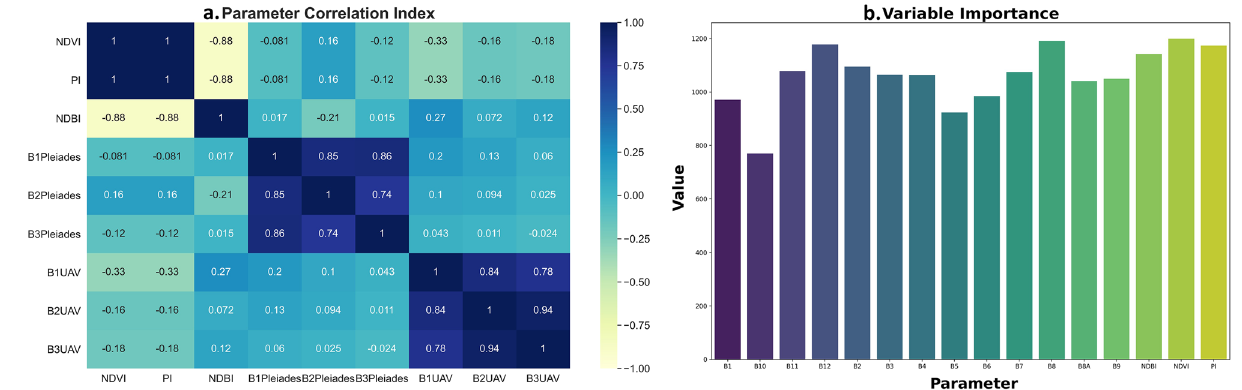
Figure 10. (a). Parameter corelation matrix index of Sentinel-2A, Pleiades, and UAV imagery, (b) value of variable contribution in product development of